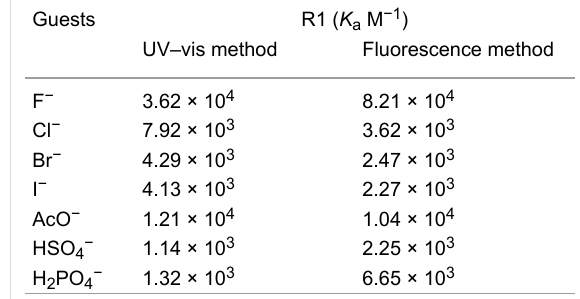
Figure 5: The Job plot of 1 with fluoride ion from UV method in CH 3 CN/H 2 O (4:1 v/v).